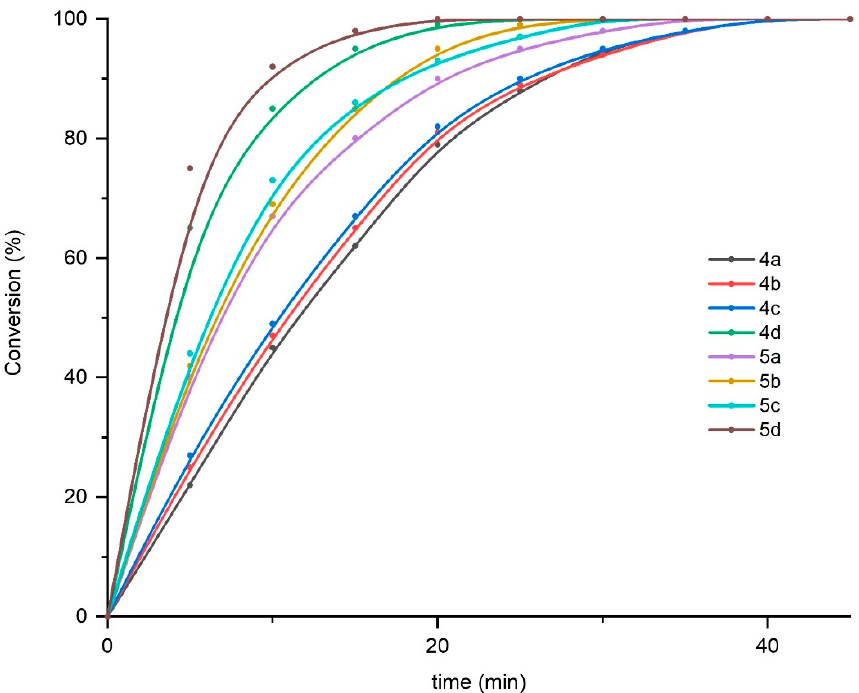
Figure 5. Time/conversion curves for RCM transformations of 7 (0.8 mmol, 200 mg) to 8 under the action of catalysts 4a – d and 5a – d . Conditions: catalyst loading is 0.01 mol% (0.00008 mmol), 25 °C, Ar, dry CH 2 Cl 2 (20 mL).